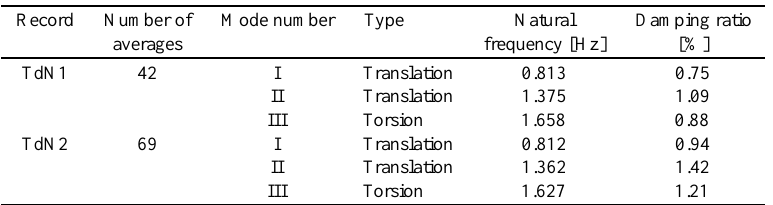
Table 2 Output-only modal identification results (EFDD)